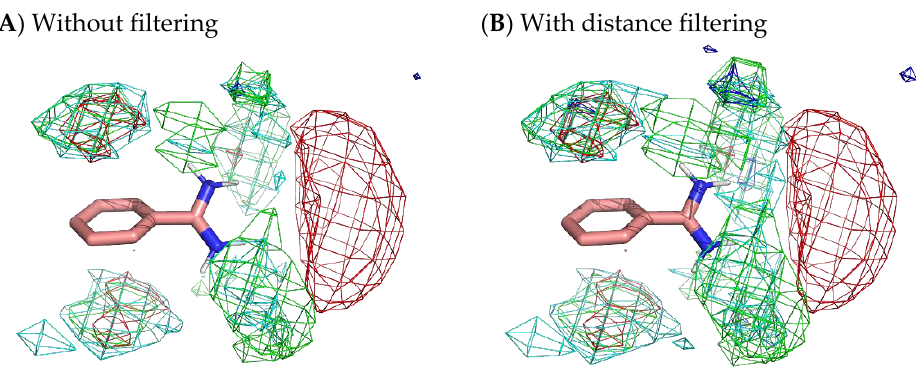
Figure 10. Comparison of residue interaction profiles of benzamidine obtained from MSMD simulation with and without consideration of moving distance of probe molecules. ( A ) Without the selection of stable probe molecules (note that it is the same figure as Figure 4); ( B ) with the selection of stable probe molecules. Green, cyan, gray, blue, and red meshes indicate profiles of hydrophobic, hydrophilic, aromatic, basic, and acidic residues, respectively.